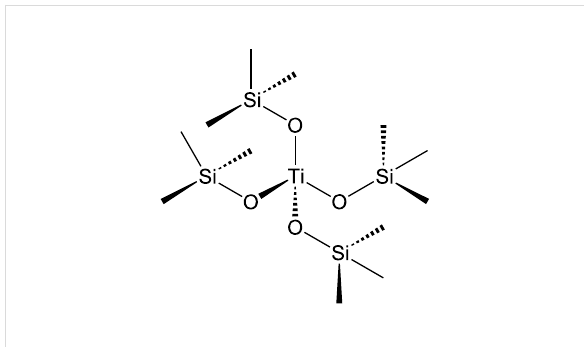
Figure 9: Isolated, tetrahedrally coordinated Ti(IV) site. Reprinted from [168]. Copyright 2008, with permission from Elsevier.